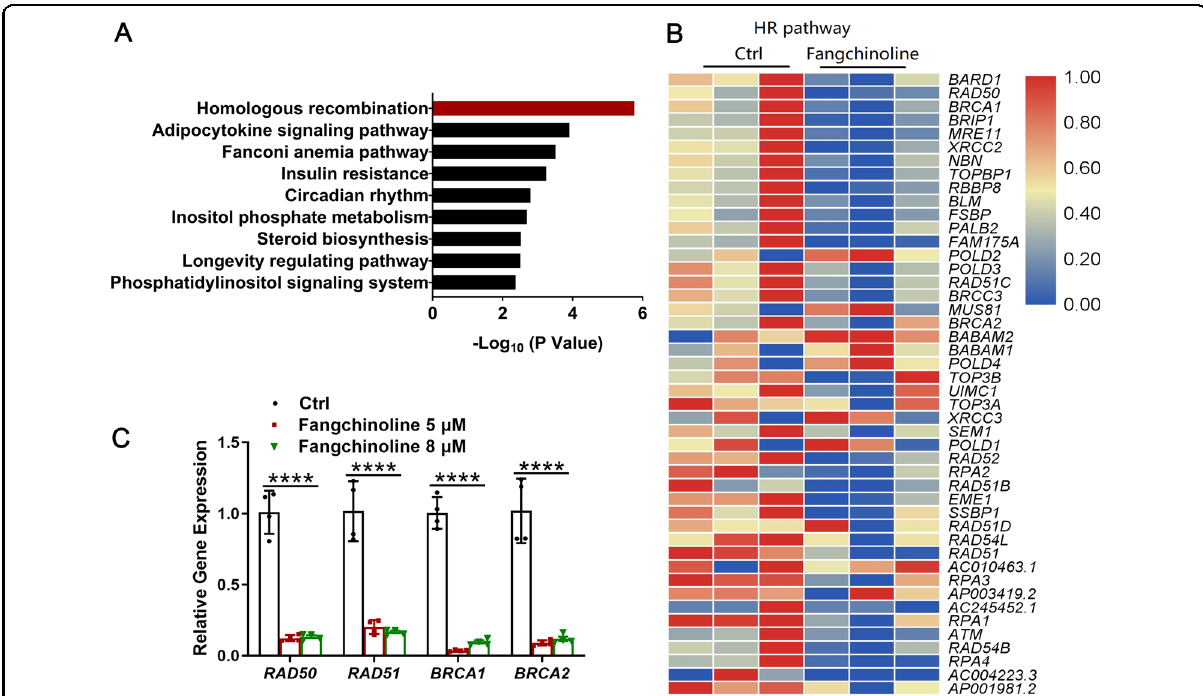
Fig. 2 The effects of fangchinoline on the HR pathway in CM-AS16 cells were determined by transcriptome analysis and qRT-PCR. A KEGG enrichment analysis of DEGs altered by 8 μ M fangchinoline. All pathways signi fi cantly enriched in the DEGs (adjusted P < 0.01) were included. B A heat map depicting DEGs altered by fangchinoline revealed a signi fi cant correlation with the HR pathway. The colour indicates the relative gene expression value. Blue: lowest expression; red: highest expression. C Quanti fi cation of the relative expression of genes related to the HR pathway. Data represent the mean ± SD of four independent experiments. * P < 0.05, **** P < 0.0001, by Student ’ s t